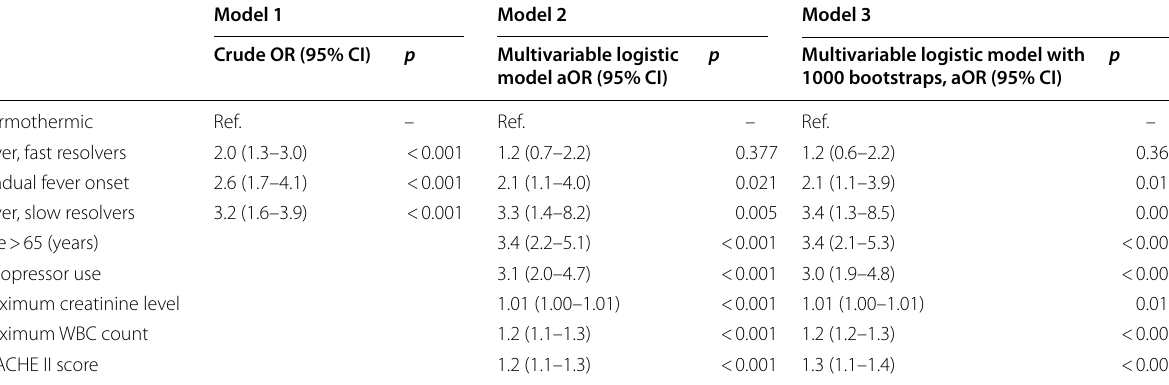
Table 4 Association between in-hospital death and temperature-trajectory phenotype in logistic regression models